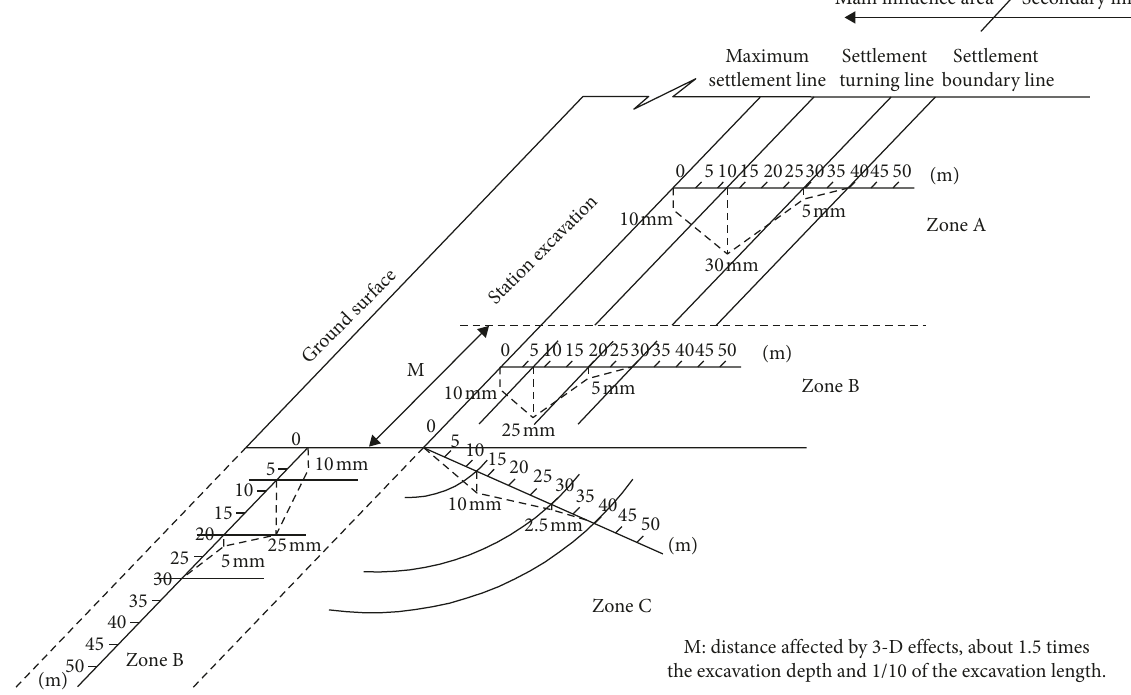
Figure 6: Partitioning of ground surface